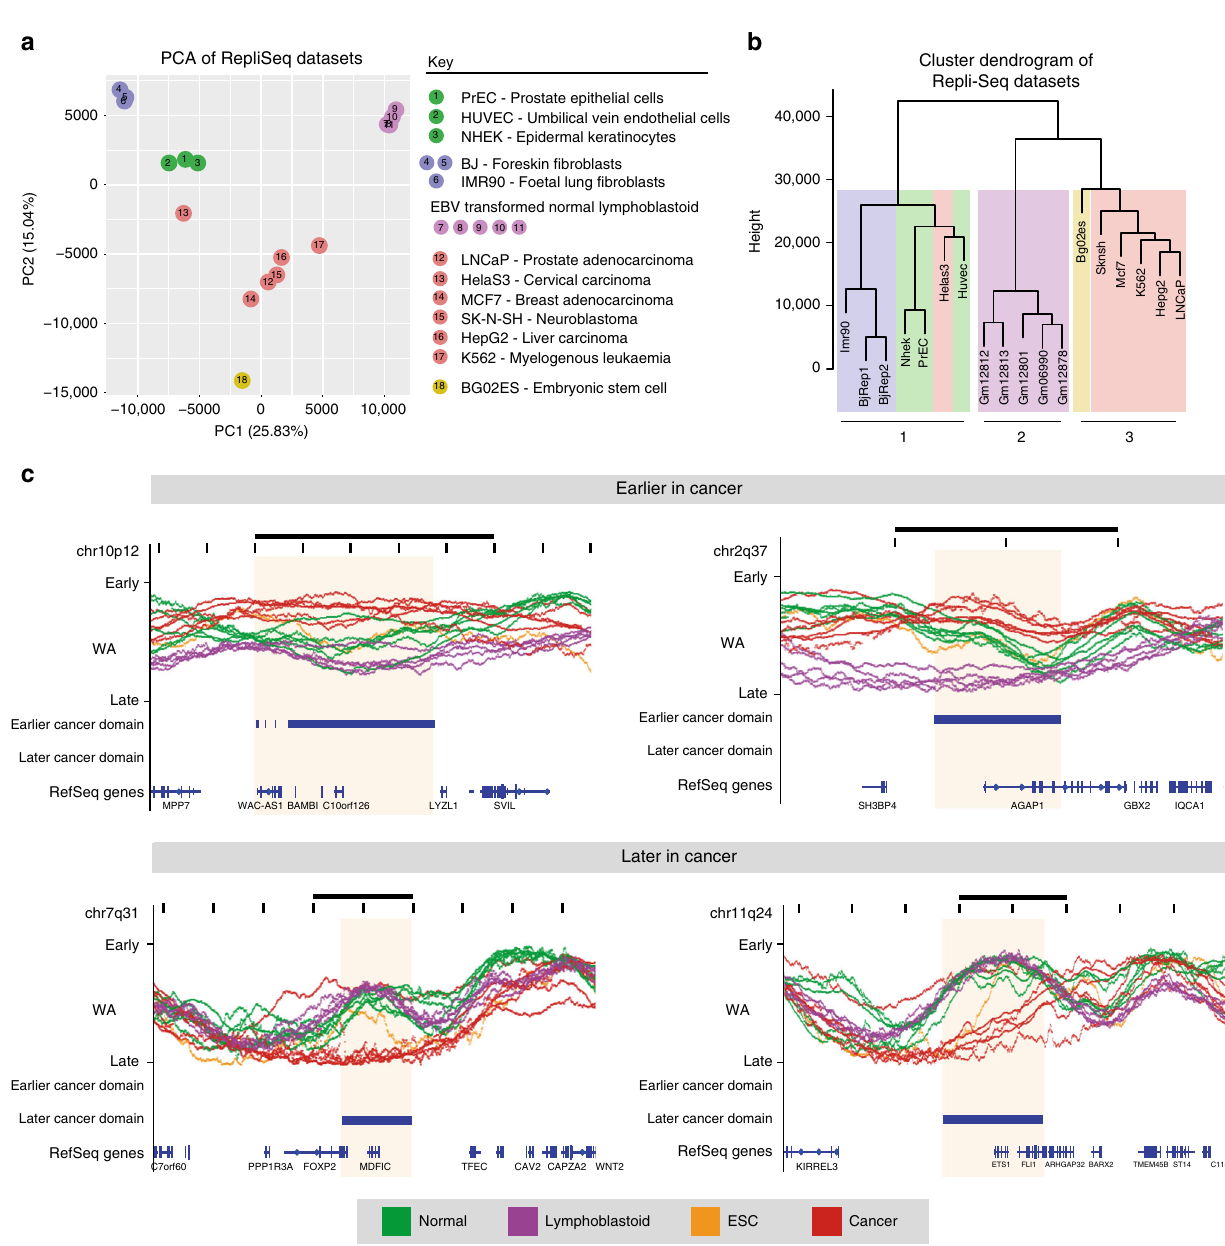
Fig. 5 Conservation of replication timing alterations in cancer. WA values of all publically available Repli-Seq datasets, including PrEC and LNCaP, are assessed using PCA ( a ) and hierarchical clustering (Ward ’ s criterion) ( b ). All clusters have a clusterwise Jaccard bootstrap mean above 0.8 indicating their stability; means are 0.9399 (cluster 1), 0.8676 (cluster 2) and 0.8225 (cluster 3). Samples are identi fi able by colour and number key. c Shown are representative examples of loci that are earlier cancer domains (ECDs) or later cancer domains (LCD) in multiple cancers compared to other cell types. Shaded boxes indicate ECDs or LCDs with logFC ≥ 1. Scale bar represents 1